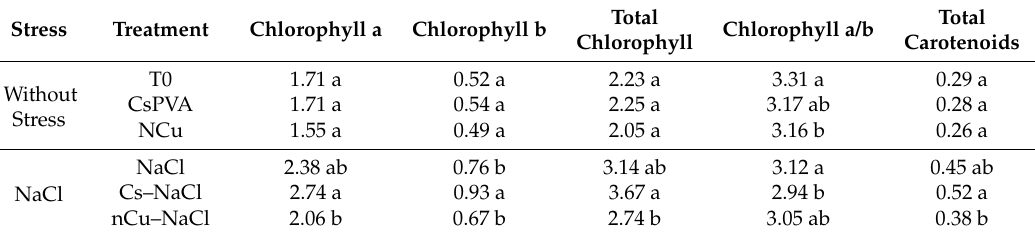
Table 2. Content of pigments on tomato leaves (mg g − 1 fresh